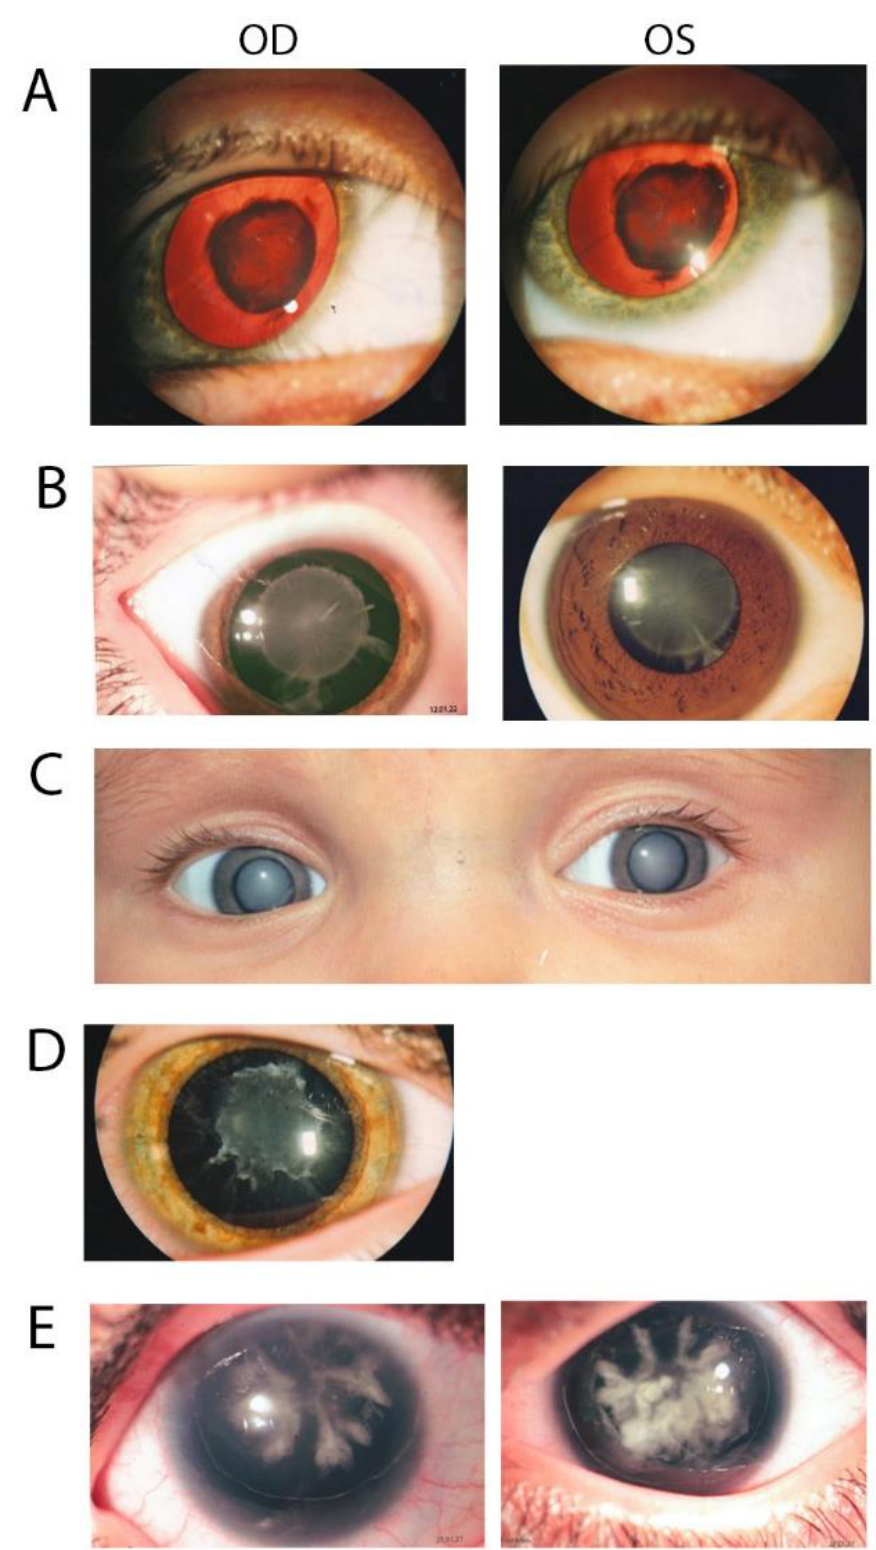
Figure 2. Photographs showing eyes of affected patients from the five families. ( A ) Red reflex image of proband 4 of family 97001 with nuclear cataract. ( B ) Image of proband 5 of family 97003 showing a congenital nuclear cataract with cortical riders. ( C ). Eye picture of proband 7 of family 97004 with congenital nuclear cataract. ( D ) Image of proband 7 of family 97006 showing congenital nuclear cataract. ( E ) Image of proband 3 of family 97008 with a coralliform congenital cataract.